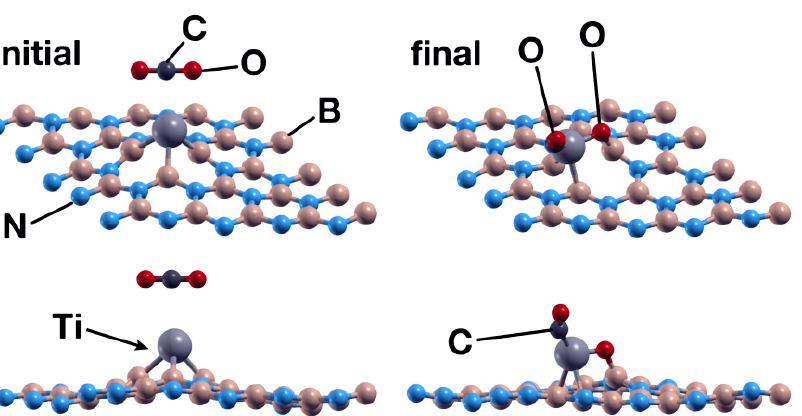
Figure 14. Initial ( left ) and final ( right ) configurations for the interaction of the hBN surface with a Ti absorbed in an N vacancy and a CO 2 molecule. The titanium atom acts as a catalyst to chemisorb the CO 2 molecule in the system.